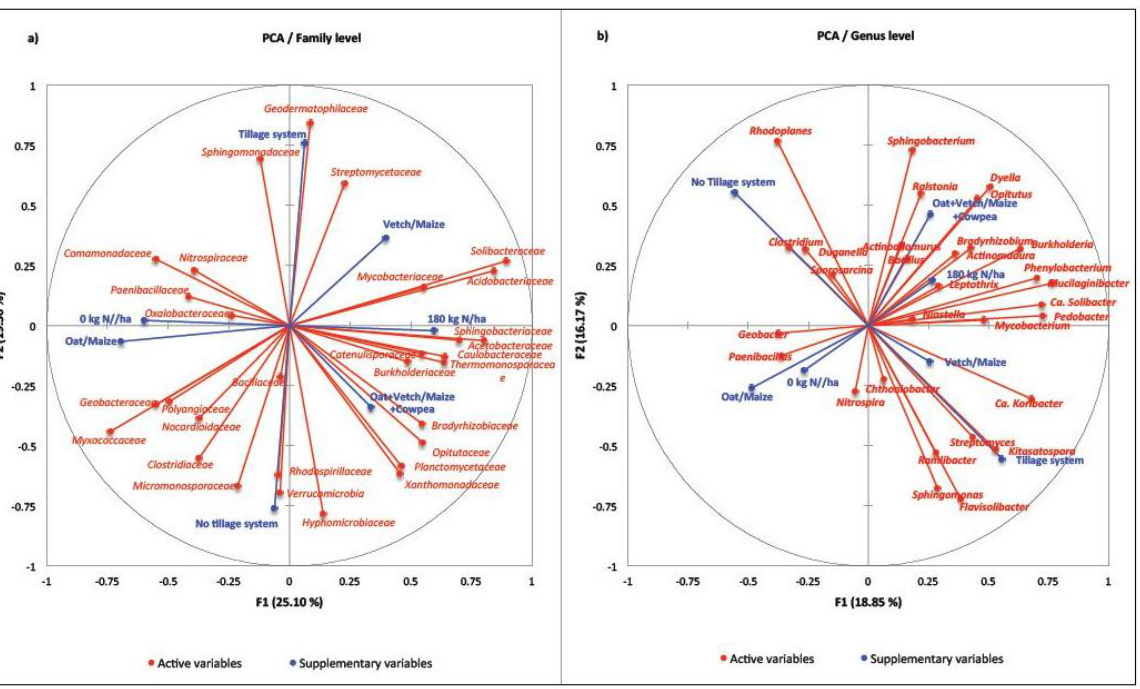
Figure 3. Principal component analysis (correlation-based PCA), between the 30 most abundant families (a), and genera (b). The treatments were used as supplementary